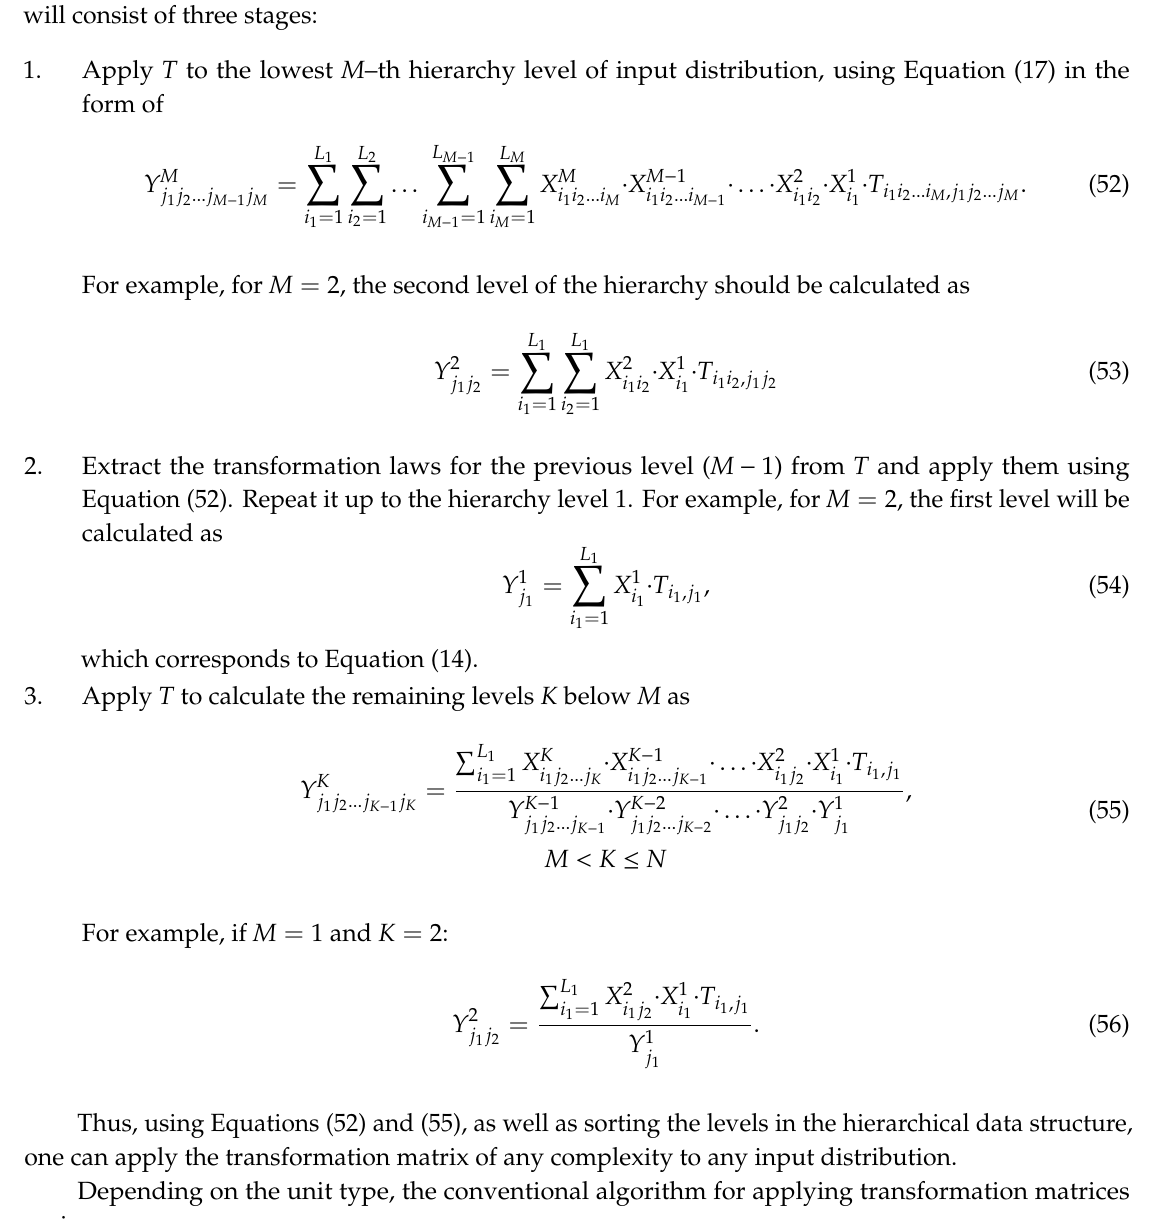
Figure 3. The scheme of application of the transformation matrix for the 𝑁 –dimensional distribution.